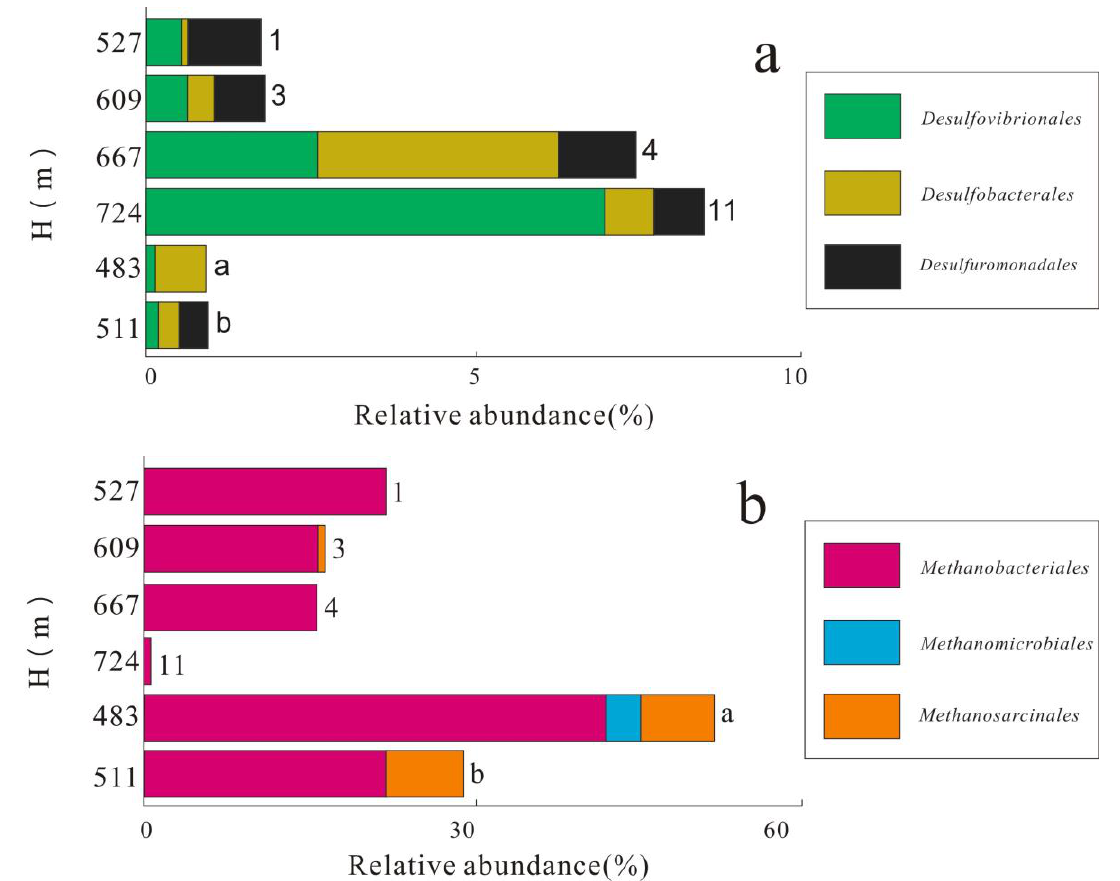
Figure 8. ( a ) Relative abundance of sulfate reducing bacteria at the order level; ( b ) relative abundance of methanogens at the order level.